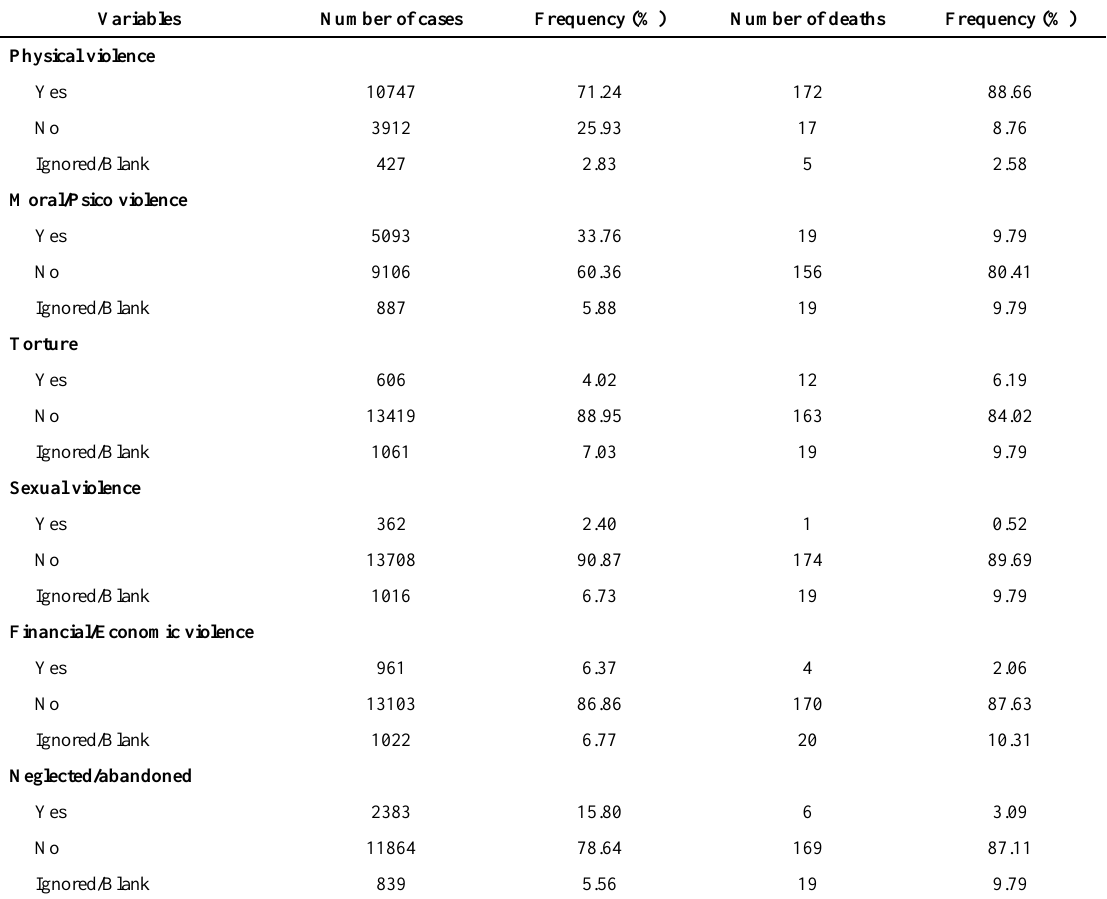
between 2007 and 2017